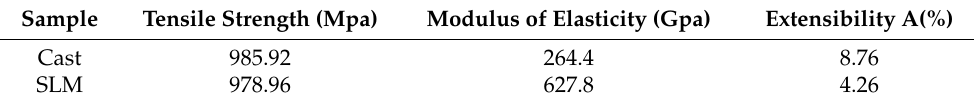
Table 3. The mechanical properties of CoCrMo under different